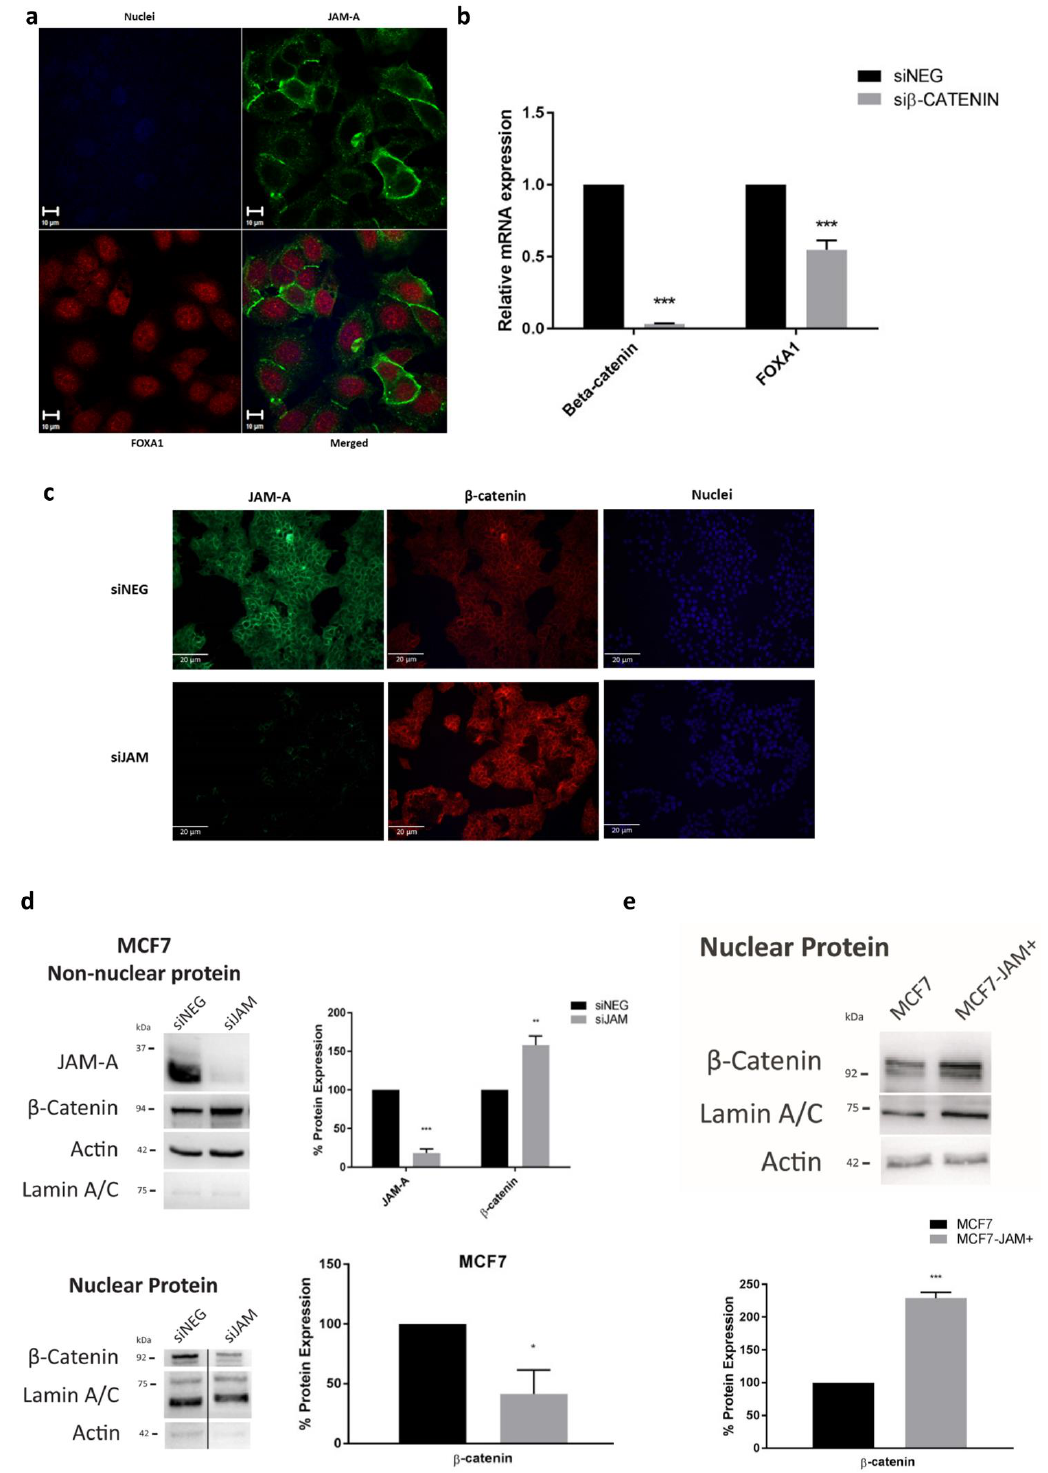
Figure 5. JAM-A expression influences β-catenin presence in the nuclear and non-nuclear fraction of breast cancer cells. ( a ) MCF7 cells were subjected to double immunofluorescence labeling for JAM-A and FOXA1, with a counter-stain of DAPI (blue) to highlight the nuclei. Confocal microscopy for JAM-A (green) and FOXA1 (red) revealed no spatial overlap of these proteins within the cells. ( b ) MCF7 cells were transfected with 25 nM of control siRNA (siNEG) or a pool of β -catenin siRNA and harvested 72 h later for qRT-PCR analysis. Results show FOXA1 mRNA expression was reduced following